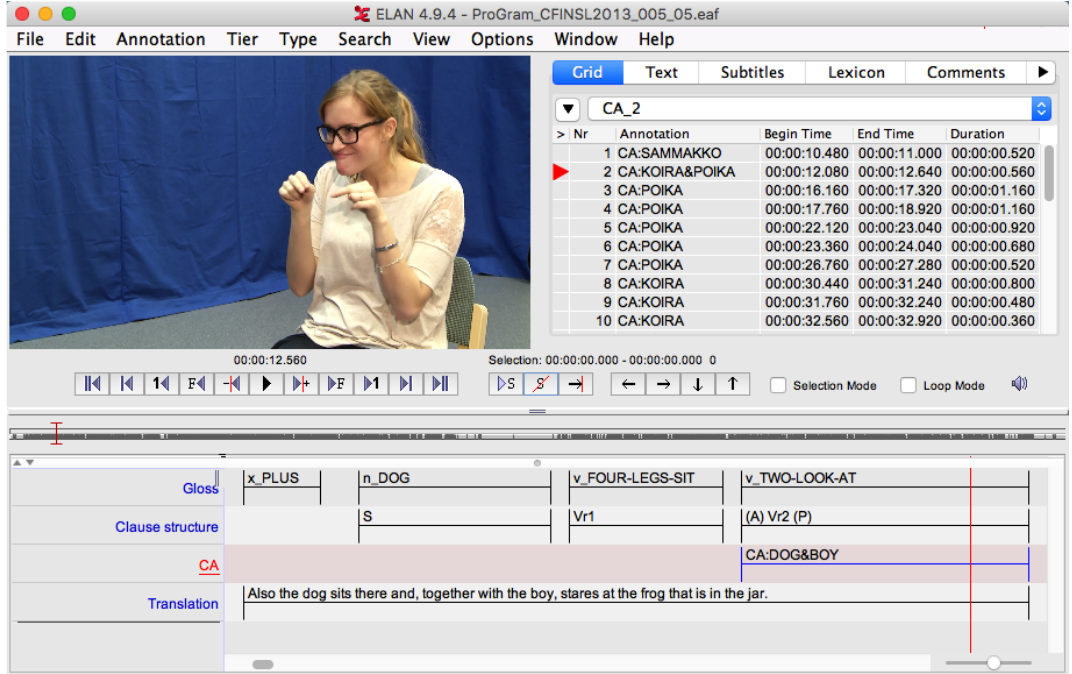
Figure 4. ELAN screenshot showing CA conveying core argument information in